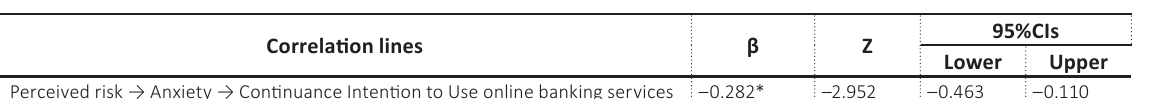
Table 4. Indirect effect